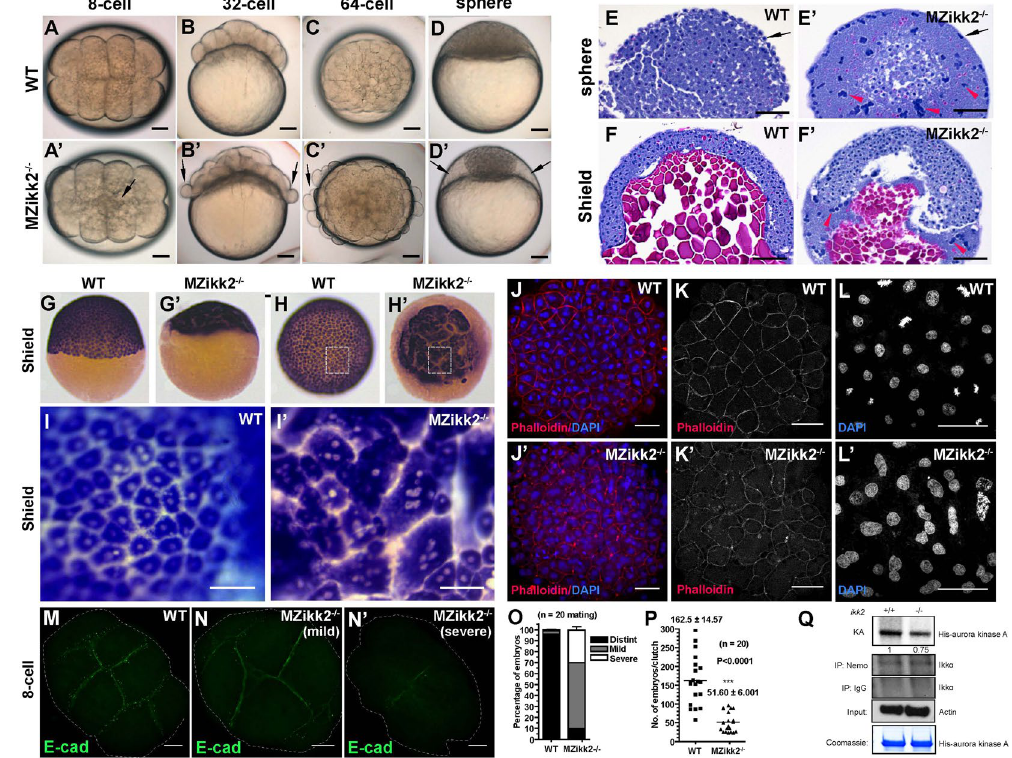
Figure 5. Cell adhesion and cytokinesis are affected in MZikk2 − / − embryos. ( A – D ) Early cell adhesion and cytokinesis defects in MZikk2 − / − embryos (obtained from homozygotic parents, arrow) were followed by the ‘cellular island’ phenotype (arrow) at sphere stage. ( E , F ) ( H , E) stained sections showing abnormal nuclear clumps in the EVL (arrow) and enlarged YSL (arrowhead) of MZikk2 − / − embryos. ( G - I ) krt8 WISH reveals multinuclear cells in MZikk2 − / − embryos. ( I , I ′ ) Blowup of boxed areas in ( H , H ′ ), respectively. ( J–L ) Whole-mount immunostaining using Phalloidin and DAPI shows cell boundaries ( K , K ′ ) and nuclei ( L , L ′ ) in MZikk2 − / − embryos (animal pole view, sphere stage). ( M , N ) Cell division furrows stained by E-cadherin, 8-cell stage. ( O ) Quantification of embryos with mild and severe division furrow defects based on E-cadherin staining. ( P ) A number of embryos in ikk2 − / − crosses as compared to wild-type; p < 0.001, Student’s t test. ( Q ) Ikk2-dependent phosphorylation of Aurora-A in extracts of ikk2 − / − and controls. Actin and Coomassie blue, loading control. All data are expressed as mean ± SEM; Scale bar in all panels: 100 μ